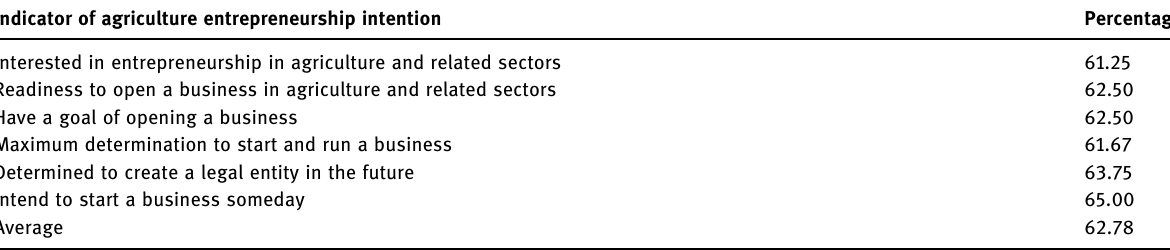
Indicator of agriculture entrepreneurship